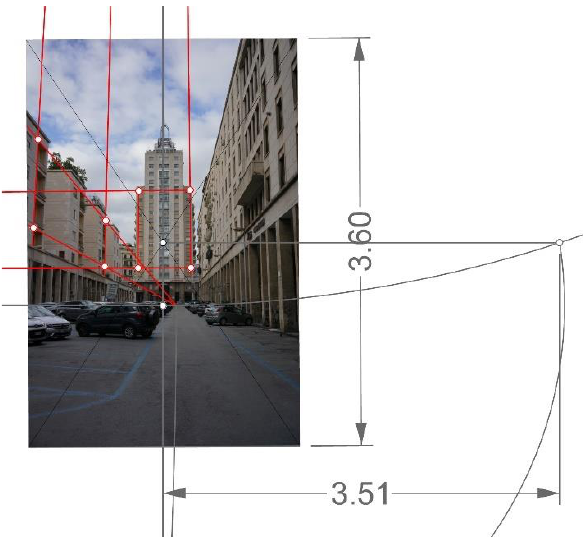
Figure 15: Inner orientation of the image taken with a standard mirrorless camera.